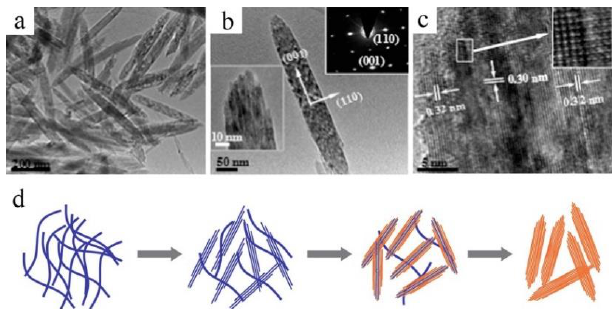
Figure 11. ( a , b ) TEM and ( c ) HRTEM images of rutile TiO 2 mesocrystals formed by conversion of titanate nanowire precursors in HNO 3 aqueous solution without any additives. The lower left inset in ( b ) is an enlarged TEM image, and the upper right inset is the SAED pattern related to the whole particle. ( d ) Schematic illustration of a tentative mechanism for the formation of rutile TiO 2 mesocrystals. Reprinted with permission from [61]. Copyright Royal Society of Chemistry, 2012.